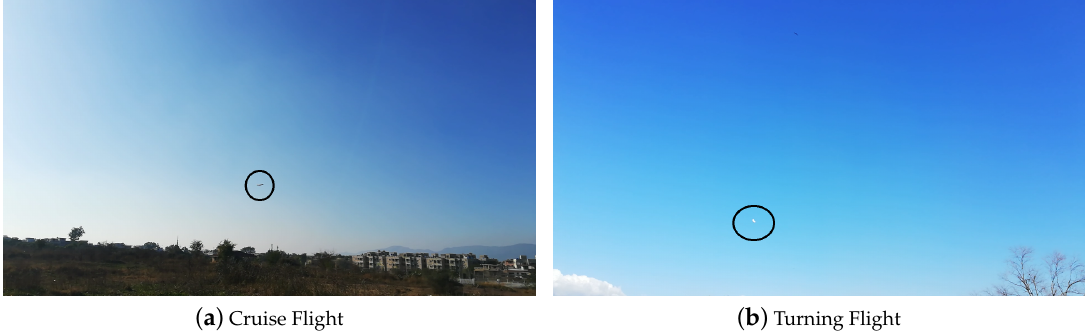
Figure 8. Flight tests of FWMAV. This figure shows successful flight during cruise and turning mission